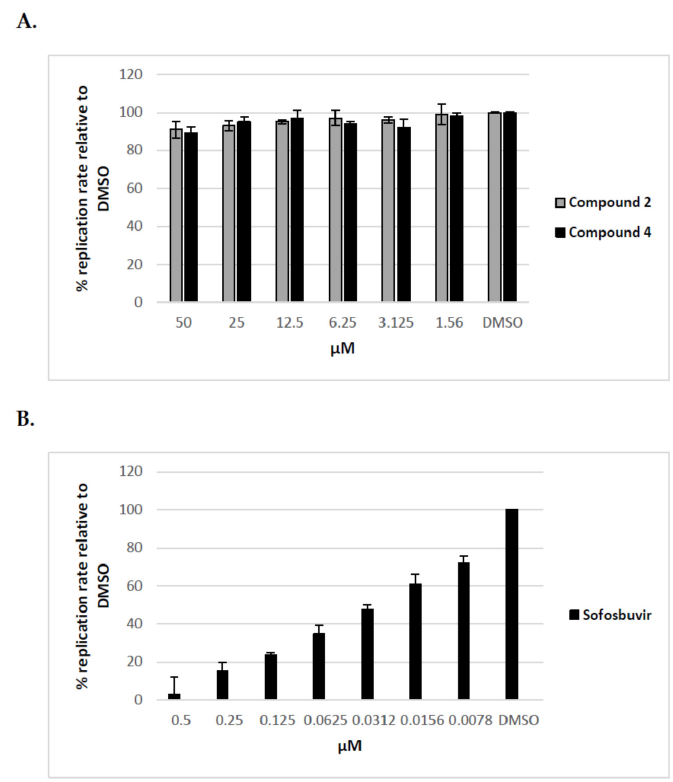
Figure 5. The influence of uridine derivatives of 2 ‐ deoxy sugars and sofosbuvir on HCV replication. Huh7-J17 cells were plated together with serial dilutions of compound 2 and 4 ( A ) or sofosbuvir ( B ) for 72 h followed by luciferase activity measurement in cell lysates. DMSO ‐ treated cells are expressed as 100%. Error bars indicate standard deviations from three experiments.